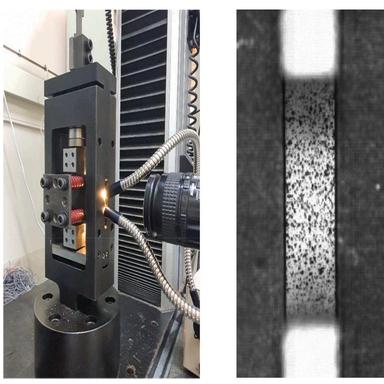
Experimental setup for in-plane compression tests: (a) a compression test jig mounted to a universal testing machine and (b) throughthickness image for DIC method.